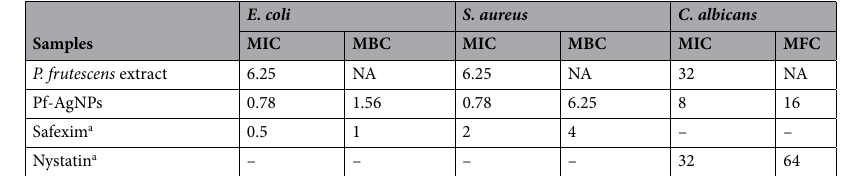
Table 1. Antimicrobial activity of Perilla frutescens (L.) extract and Pf-AgNPs (mg/mL). NA not active. a MIC and MBC of antibiotics were presented as